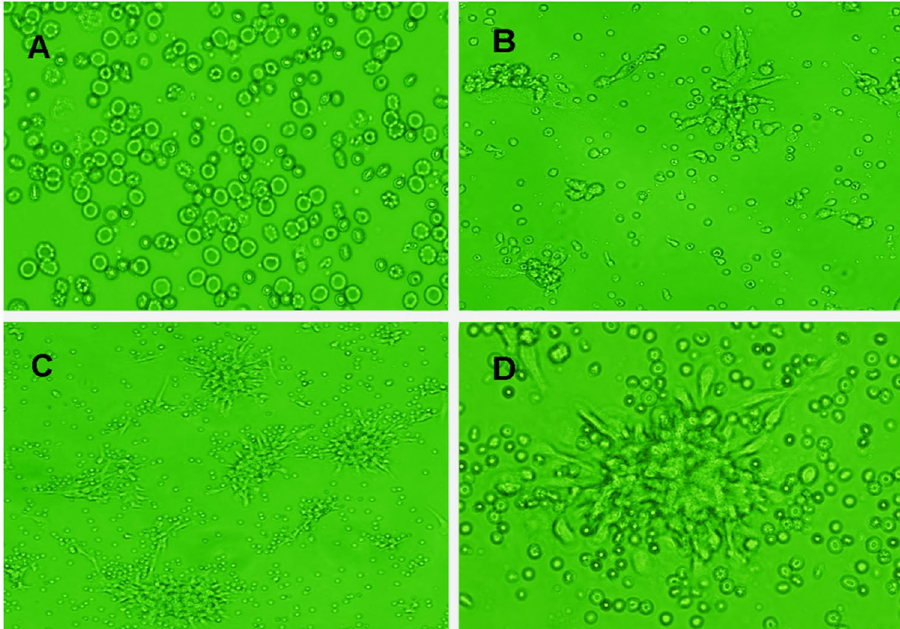
Figure 1. Rat peripheral blood-derived EPCs in culture. When peripheral blood mononuclear cells (MNCs) were cultured on fibronectin, attached cells ( A ) and typical morphology (spindle cell shape) of rat EPCs were observed after a few days of culture ( B ). Culture of MNCs resulted in the emergence of colonies with characteristic spindle-shaped EPCs. The colonies were well-formed after seven days of culture ( C , D